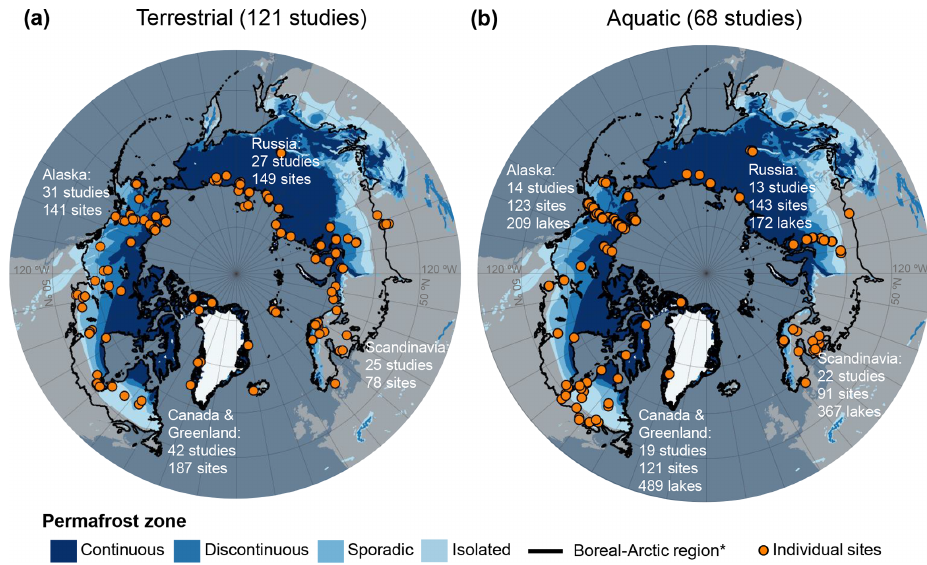
Figure 1. Maps of the individual sites (orange circles) incorporated in BAWLD-CH 4 . (a) Sites included in the terrestrial flux dataset. (b) Sites included in the aquatic flux dataset. The number of “sites” in the terrestrial dataset represents site years, which in some cases represent multiple years of data from one site or data from the same site reported by different studies. “Sites” in the aquatic dataset represent the reported average fluxes for one or multiple lakes. In some cases, studies reported one mean value for multiple lakes; therefore the number of lakes and the number of sites is not the same. ∗ Boreal–arctic region boundary from Olson et al. (2001). Permafrost zones are from Brown et al. (2002). Continental shoreline base layers are from Wessel and Smith (1996).